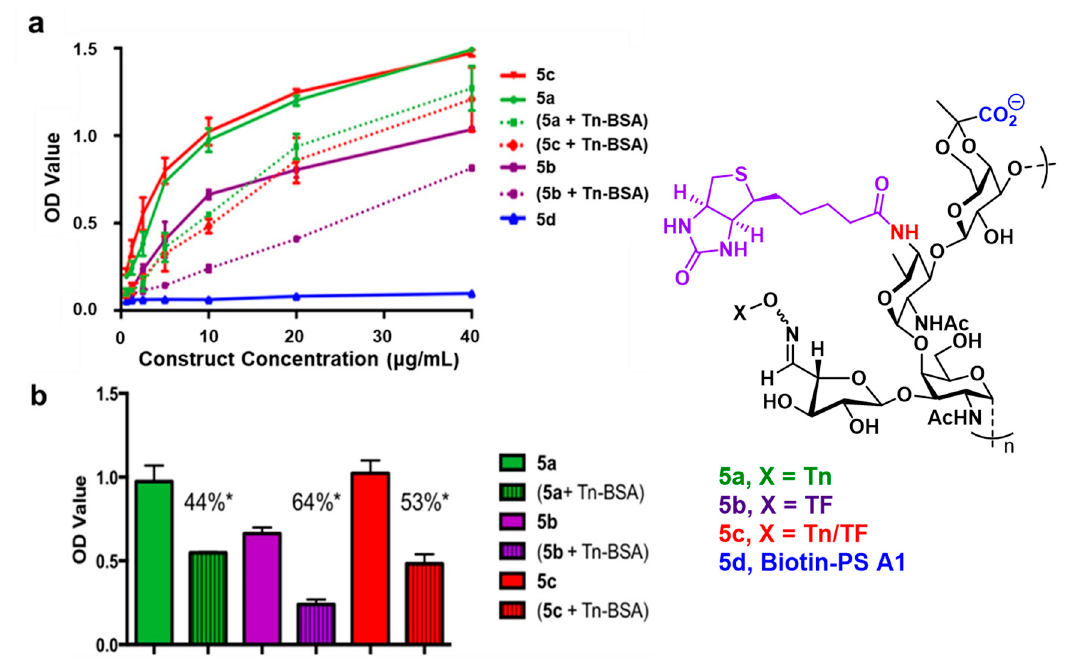
Figure 6. ( a ) MGL2 binding assay using probes 5a , 5b , 5c , and 5d (Scheme S2). ( b ) Percent inhibition by Tn-BSA in presence of 5a , 5b , 5c , and 5d . Experiments were performed in triplicate. Error bars are shown as mean ± standard error of mean. * denotes % inhibition by Tn-BSA.